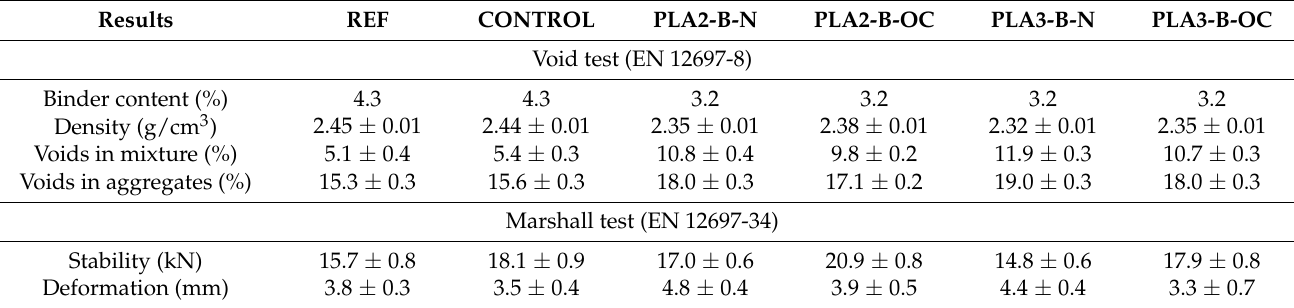
Table 6. Bulk density and air void results.